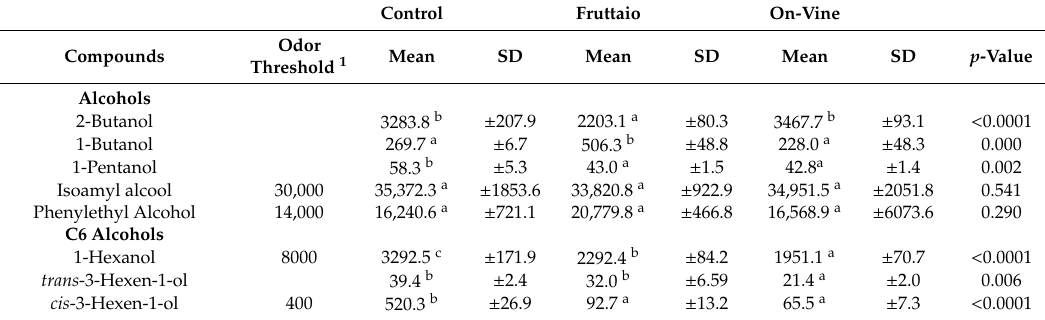
Table 1. Concentration ( µ g / L) of free compounds in young wine samples. Mean, standard deviation (SD) and ANOVA. Control